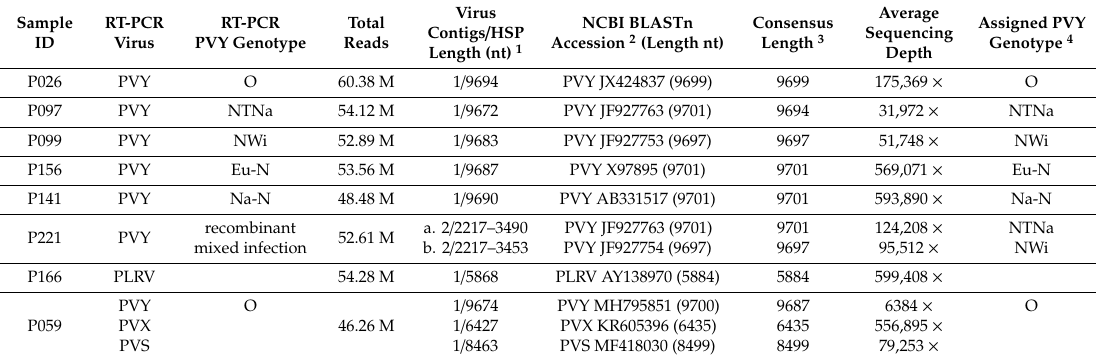
Table 3. Summary of Illumina sequencing and assembling